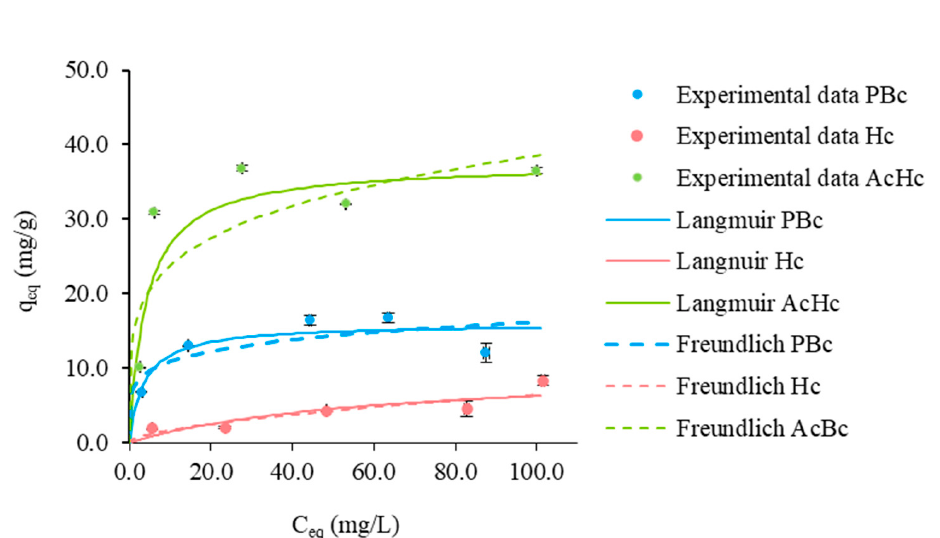
Figure 12. Isotherms for Pb (II) biosorption on PHc, Hc, and AcHc (values ± global uncertainty) at different C 0 of Pb(II), C s = 0.5 g/L biochar dosage, T = 23 ± 1 °C, 4 h contact time: experimental data and Langmuir and Freundlich